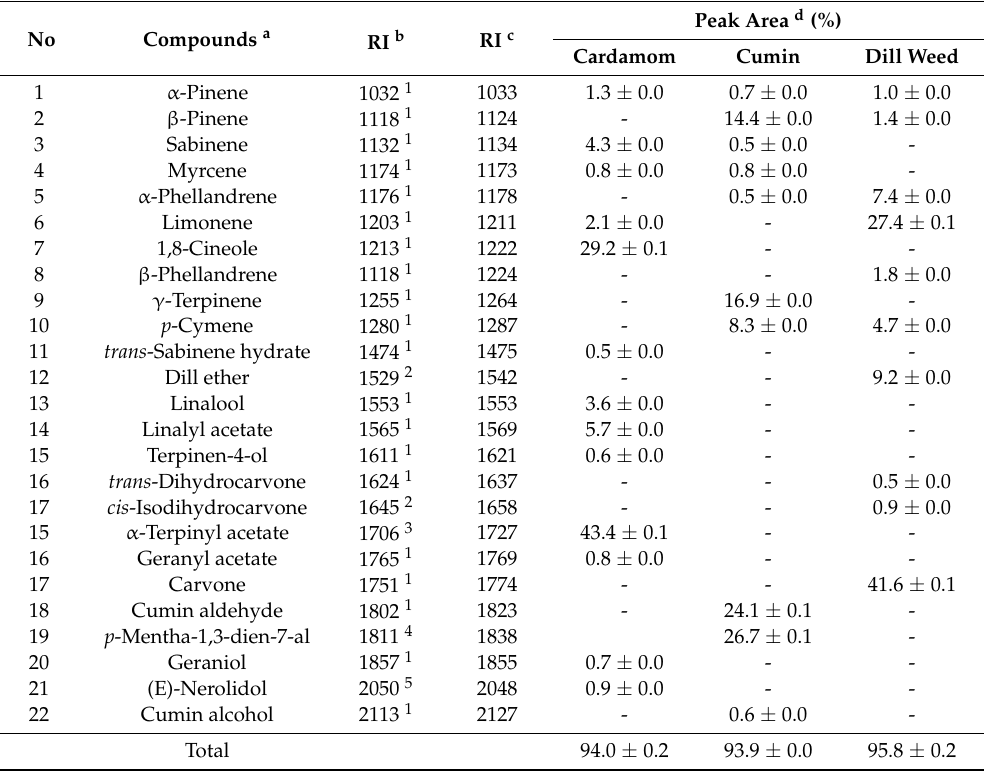
Table 1. Chemical compositions of essential oils.